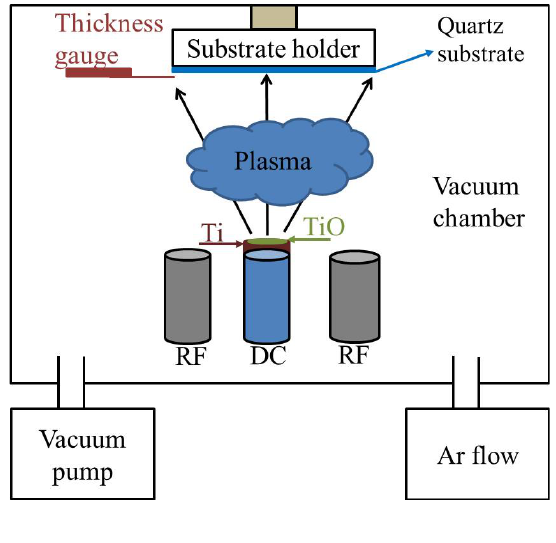
thin films were: 2